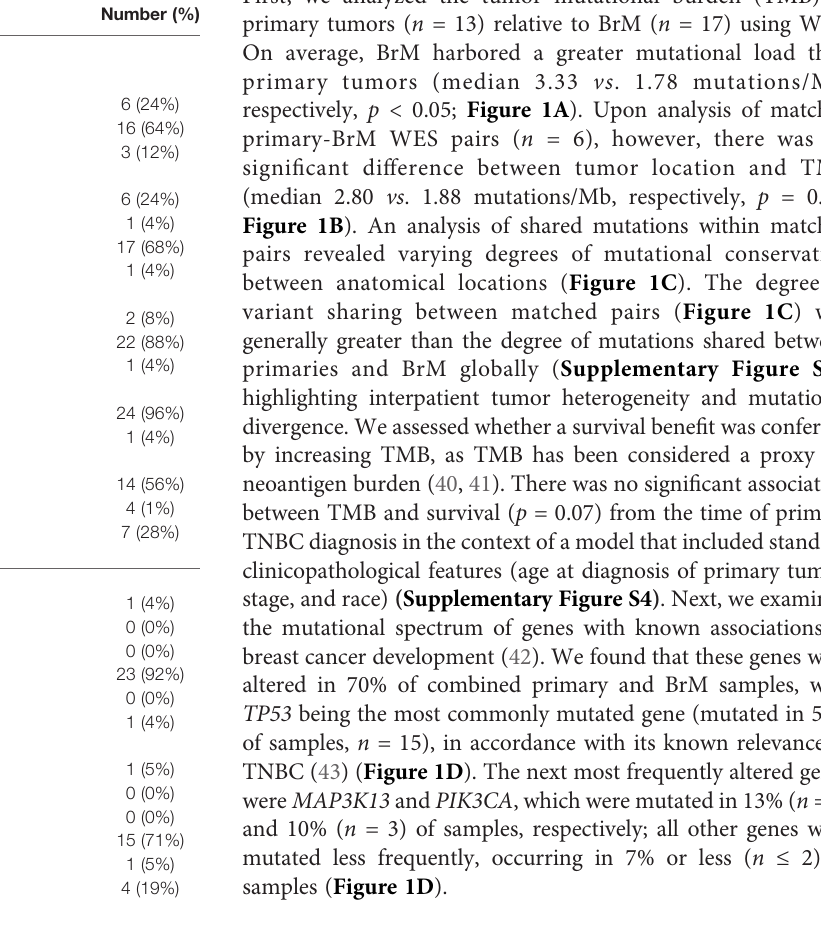
TABLE 1 | Relevant demographic, subtype, and clinical diagnostic information for the LCCC1419 TNBC cohort.